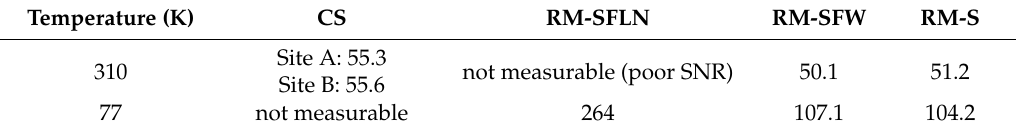
Table 2. Full width at half maximum (FWHM) data (kHz) of the peaks in Table 1.